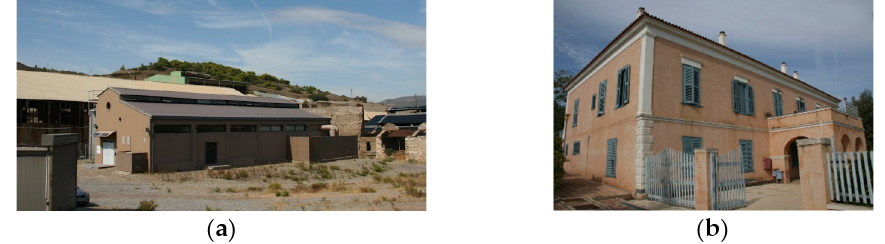
Figure 5. Testing boundaries of LTCP: ( a ) Building #1—H2 (active); ( b ) Building #2—admin (pas- sive).